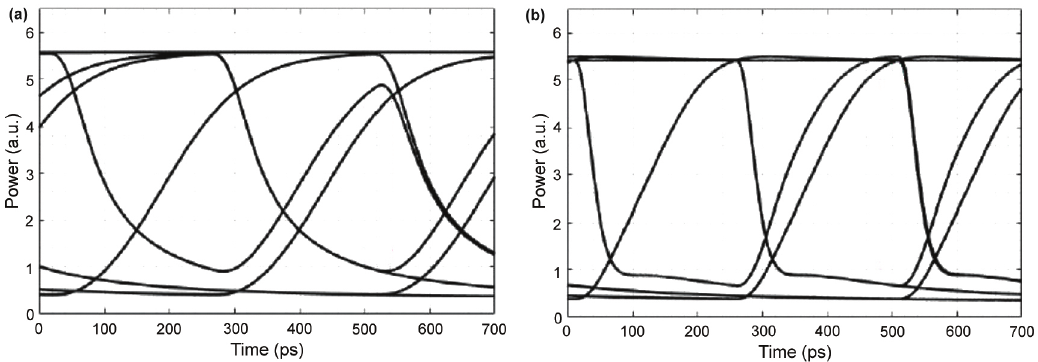
Figure 7. Simulated encoded signal eye diagrams at ( a ) RSOA output and ( b ) BFL output at 4 Gb/s.